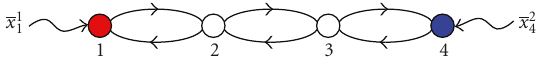
Figure 3: Dependence of the average sum rate coe ffi cient g .